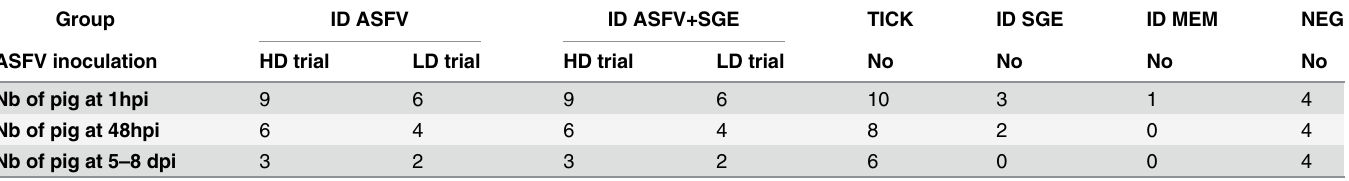
Table 1. Number of pigs per trial, treatment group and time post